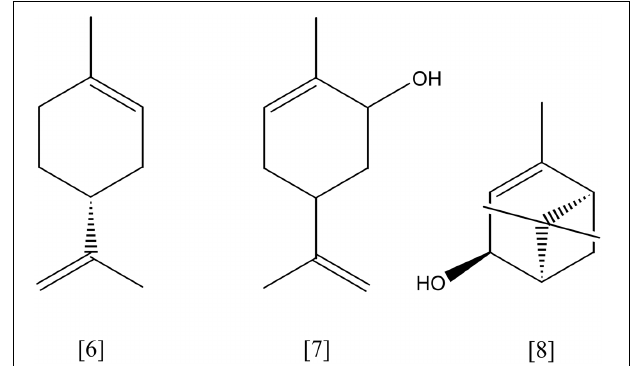
FIGURE 3 | ( R )-limonene [6]; carveol [7]; trans -verbenol